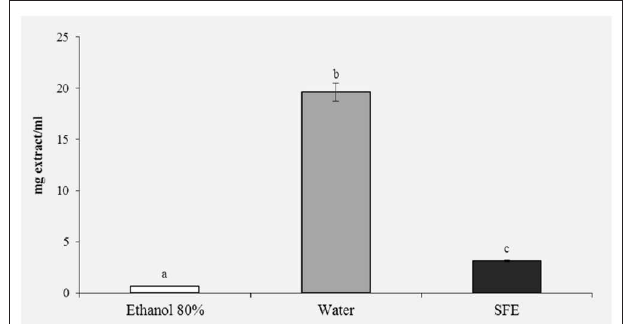
FIGURE 3 | DPPH radical scavenging activity (IC 50, mg/mL) of honey bee pollen (HBP) extracts obtained with different solvents. Lowercase letters indicate significant differences between different solvents (a, b, c: P < 0.05).